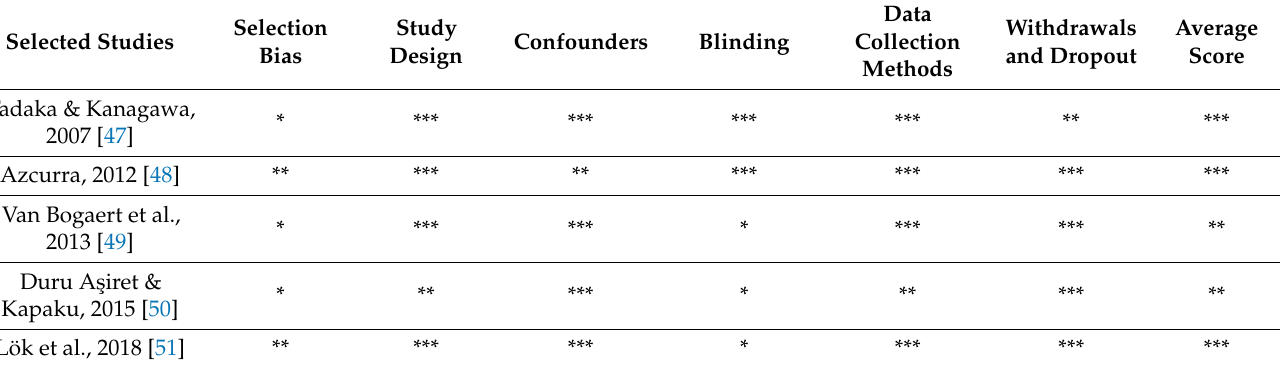
Table 2. Assessment of risk of bias of the included